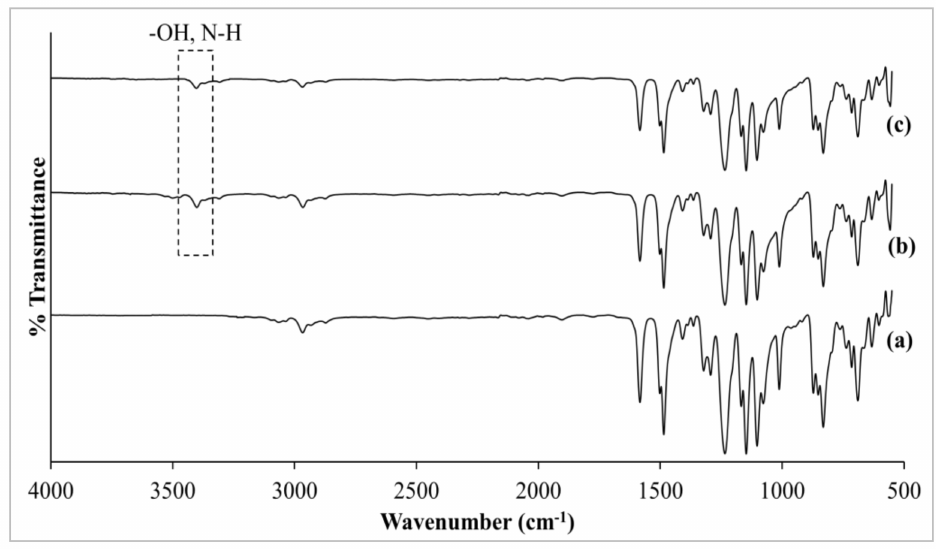
Figure 6. FTIR spectra of (a) pristine PSf membrane, (b) 5RHO/PSf, and (c) 5NH 2 -RHO/PSf